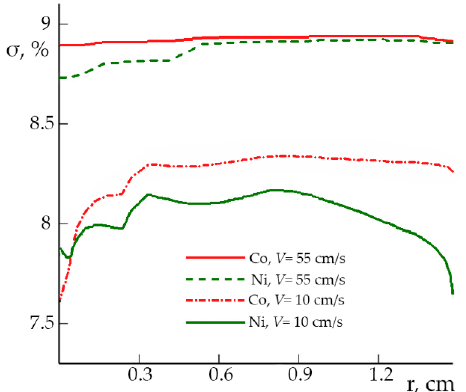
Figure 6. The laminar flow during a peripheral solution supply: radial profiles of supersaturation at the crystal surface for Co and Ni components at the inflow velocities V = 10 and 55 cm/s.